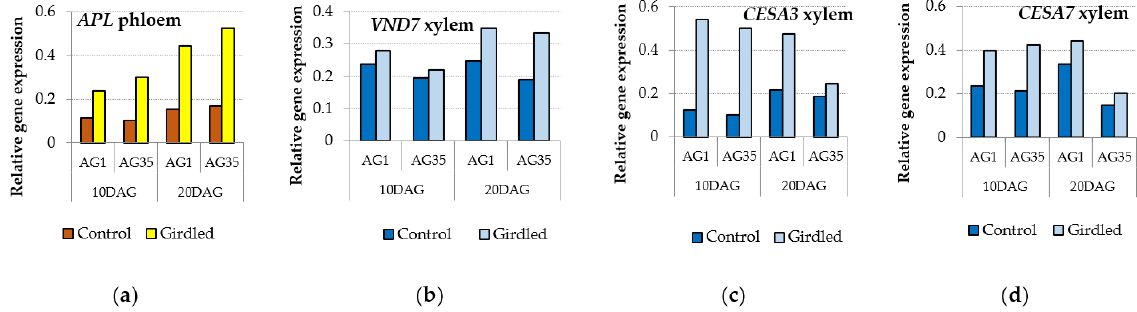
Figure 13. Relative gene expression of APL ( a ), VND7 ( b ), CESA3 ( c ), and CESA7 ( d ) genes in the phloem ( a ) and xylem ( b – d ) of control and girdled trees.